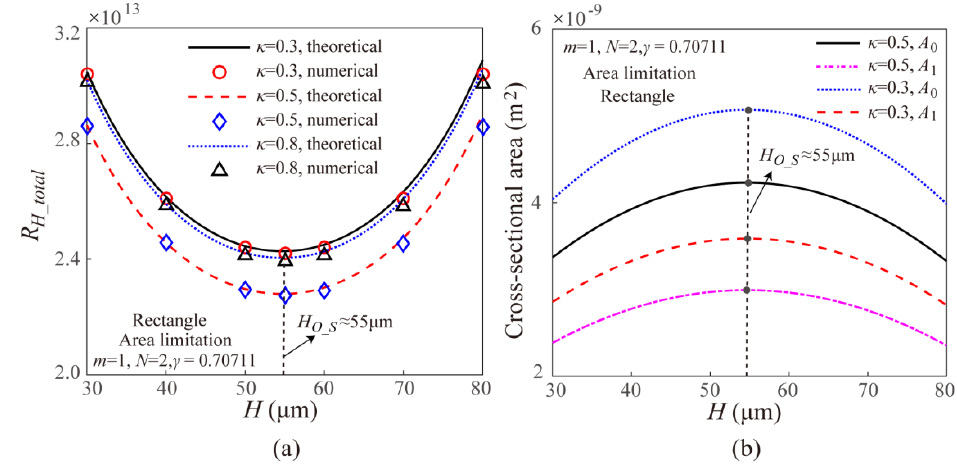
Figure 7. Effects of channel height on the ( a ) total EOF fluidic resistance and ( b ) channel cross-sectional areas of the Y-shaped elemental rectangular microchannel bifurcation with different channel width ratio under the surface area limitation.